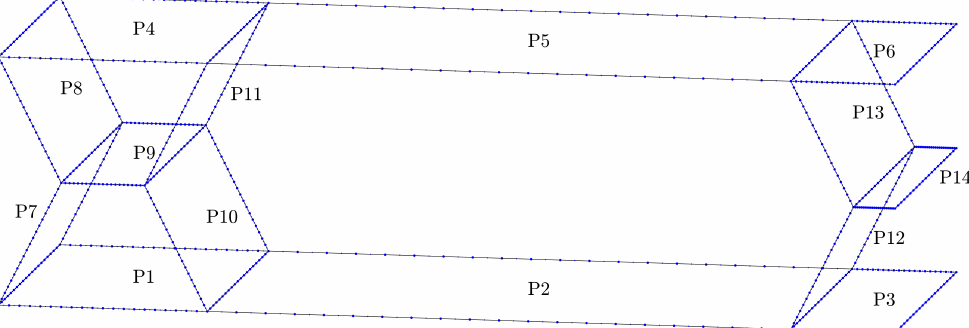
Figure 18. The converged BEM mesh. The 14 plates are labelled P1–P14. Using the converged meshes for the BEM and the FEM, the sensitivities of u max respect to the parameters in Table 2 can be calculated using the three methods introduced earlier. The results are shown in Figure 19.